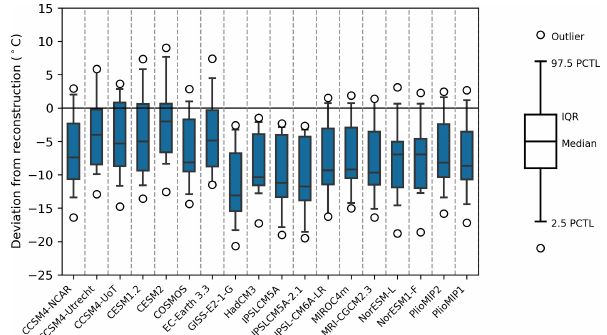
Figure 8. Box and whisker plots depicting the distribution of biases (models minus reconstruction) with biases over (under) 0 represent- ing locations where models overestimated (underestimated) recon- structed temperatures. Boxes depict the interquartile ranges (IQRs) of the distribution, whiskers extend to the 2.5th and 97.5th per- centiles, the median is displayed by a horizontal line in the boxes, and outliers (outside of the 97.5th percentile) are shown by open circles outside of the whiskers. Given the sample size of 15 recon- structions, the two outer values are depicted as outliers using these